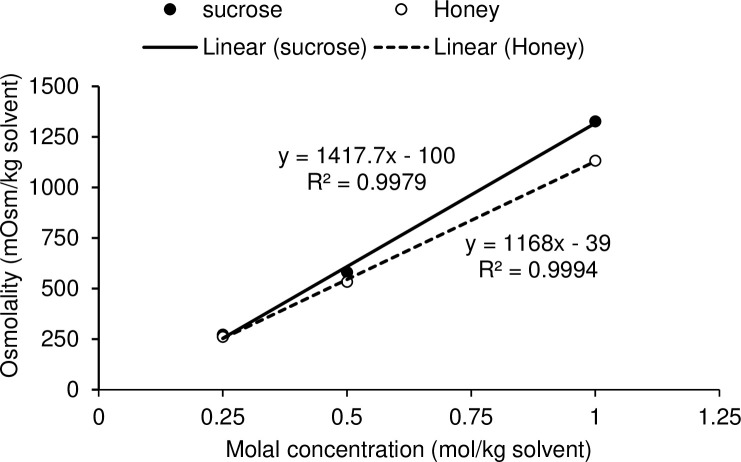
Relationship between molal concentrations and osmolalities of 0.25, 0.5 and 1 M honey and sucrose solutions.